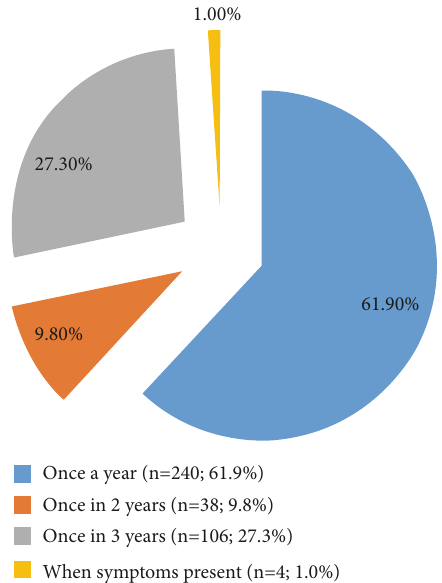
Figure 3: Frequency of cervical cancer